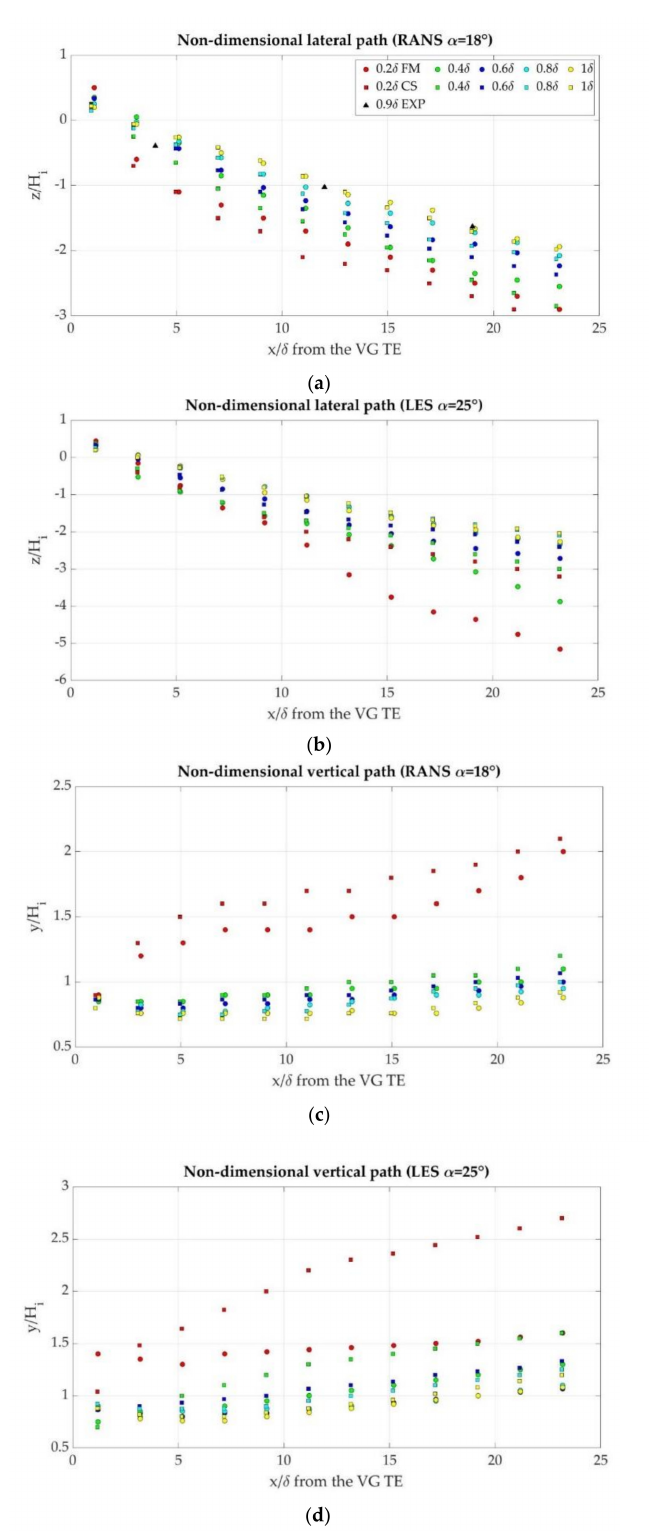
Figure 10. Non-dimensional path of the primary vortex obtained with the fully resolved mesh model (FM), the cell-set model (CS), and experimentally (EXP). ( a ) Non-dimensional lateral path with RANS, ( b ) non-dimensional lateral path with LES, ( c ) non-dimensional vertical path with RANS, and ( d ) non-dimensional vertical path with